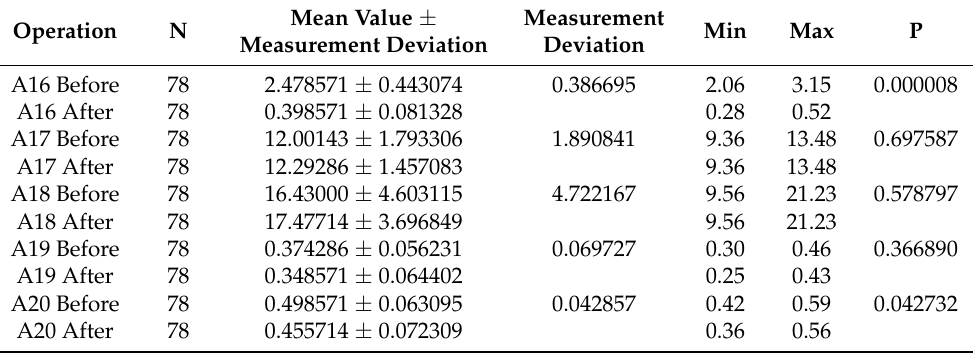
Table 8. Statistical evaluation of measured data